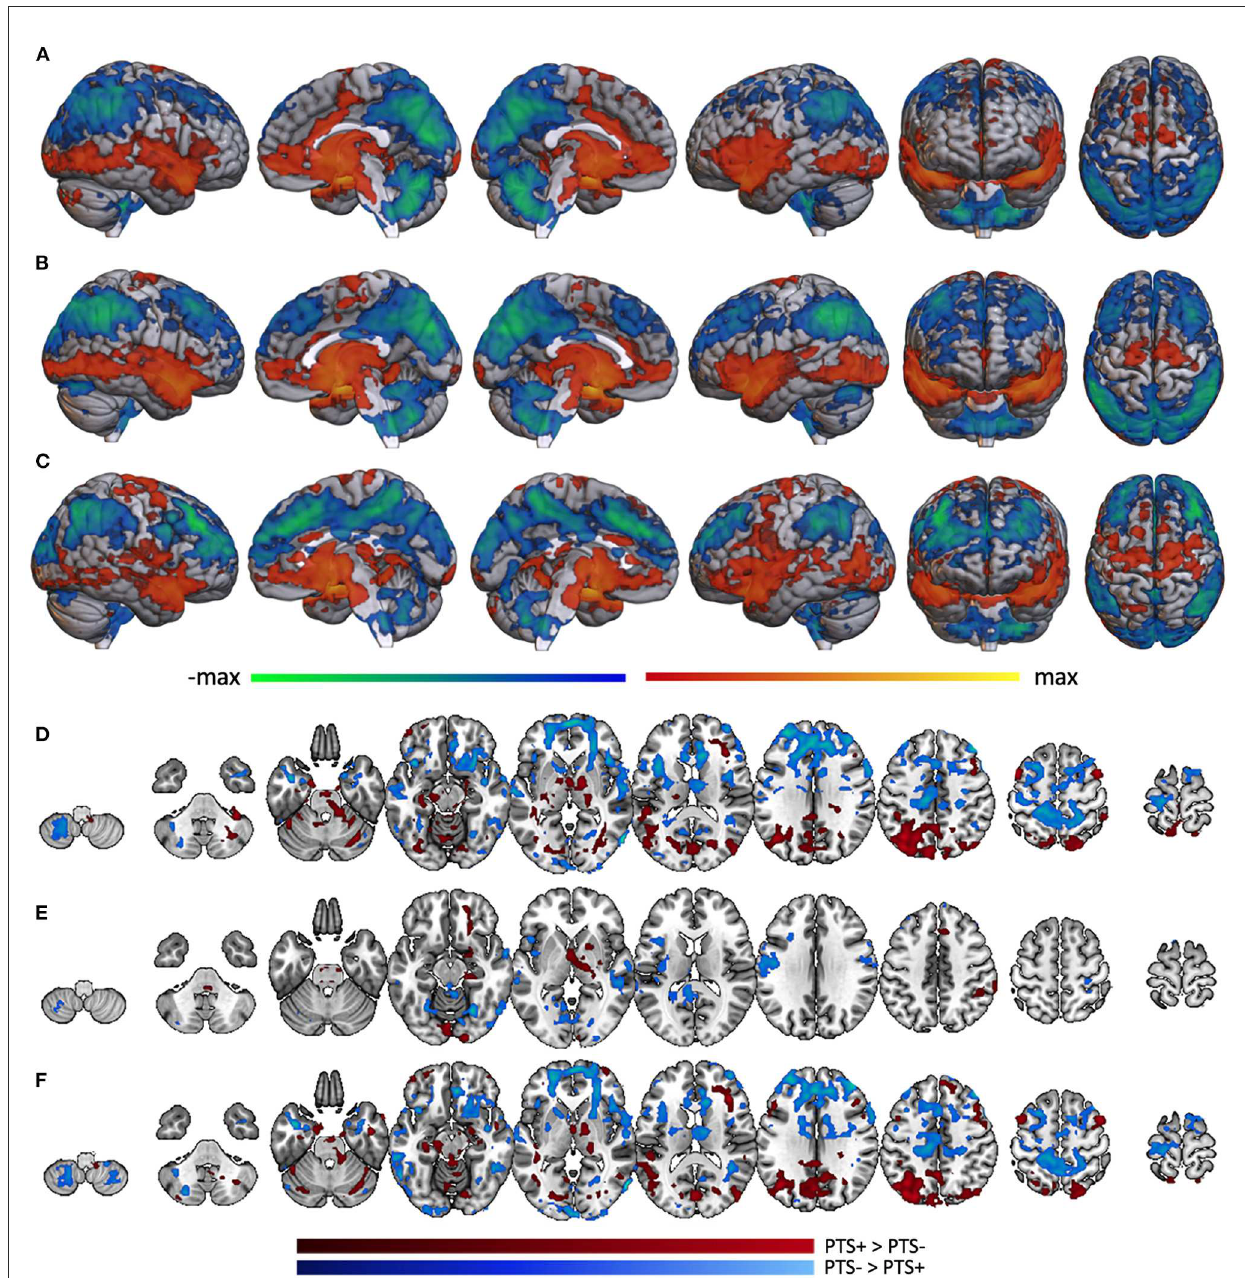
FIGURE6 Whole brain correlation with amygdala separated by PTS group. Amygdala connectivity with the rest of the brain in the (A) TBI-/PTS-group ( n = 18), (B) mTBI/PTS-group ( n = 28), and (C) mTBI/PTS + group ( n = 19). Warm colors represent significant positive correlation with amygdala; cool colors represent significant negative correlation with amygdala. Differences between amygdala connectivity in the PTS + and PTS- groups are displayed for (D) the whole group, (E) the TBI-group, and (F) the mTBI group. Maroon colors represent regions where amygdala connectivity is greater in the PTS + group; cyan colors represent regions where amygdala connectivity is greater in the PTS-